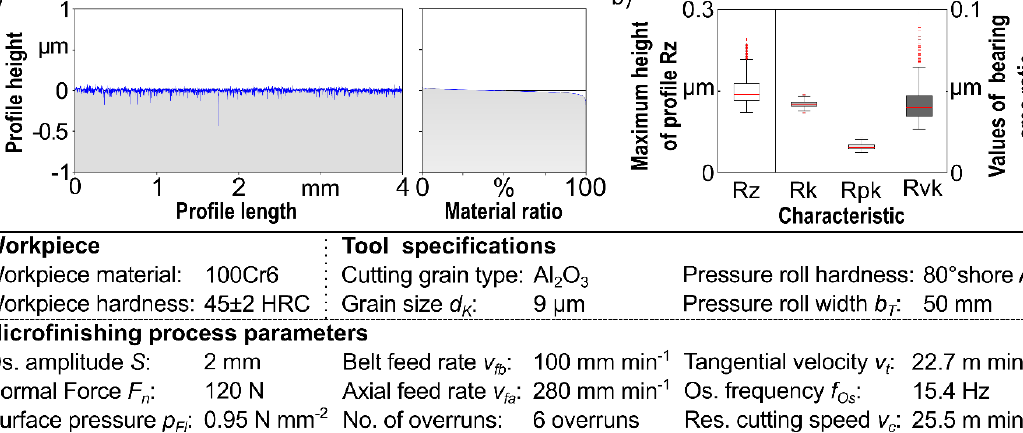
Figure 6. Resulting surface for the second fine microfinishing step by means of ( a ) the profile and material ratio curve and ( b ) surface